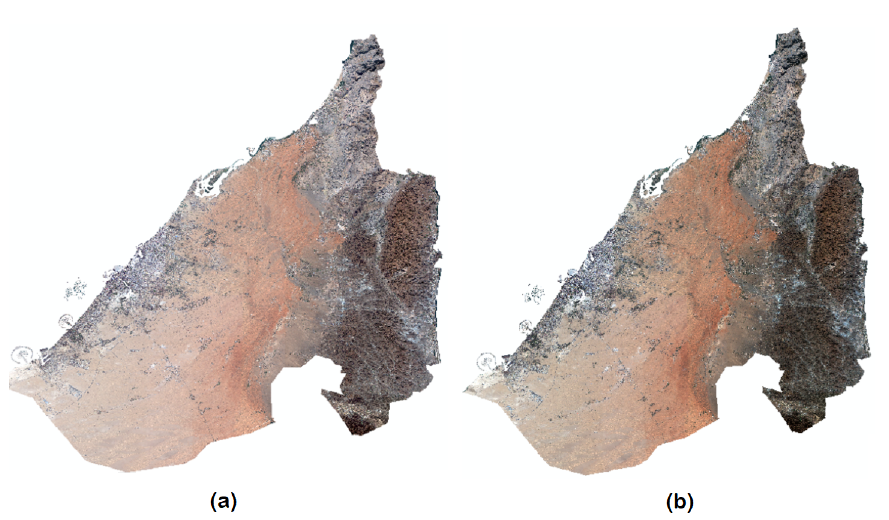
Figure 5. ( a ) Mosaicking output of WorldView-2 images; ( b ) final product after remapping of the mosaic to surface reflectance